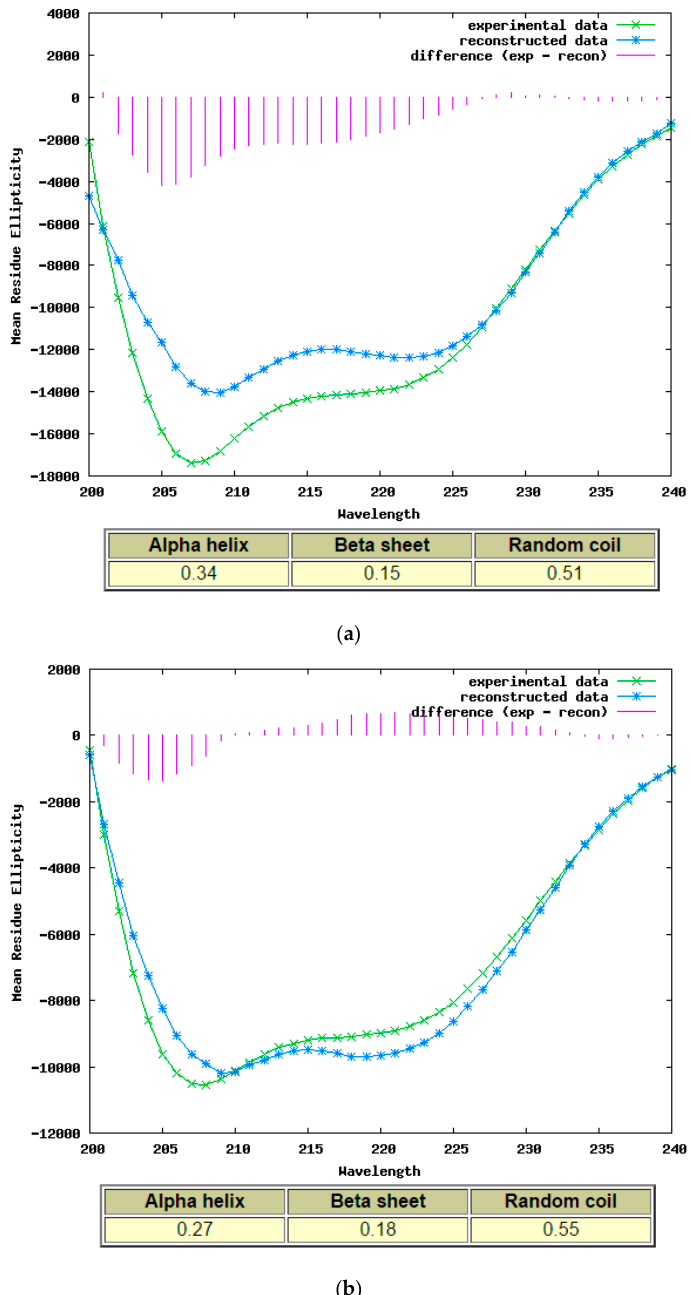
Figure 7. The CD spectra of purified synthetic ( a ) phylloseptin-PTa and ( b ) phylloseptin-PHa plotted as mean residue ellipticity (deg cm 2 dmol − 1 ) versus wavelength (nm) suggested α -helical conformation in the 10 mM NH 4 Ac with 50% TFE analysed from 240 nm to 200 nm using K2D analysis programme and processed via DICHROWEB online server.